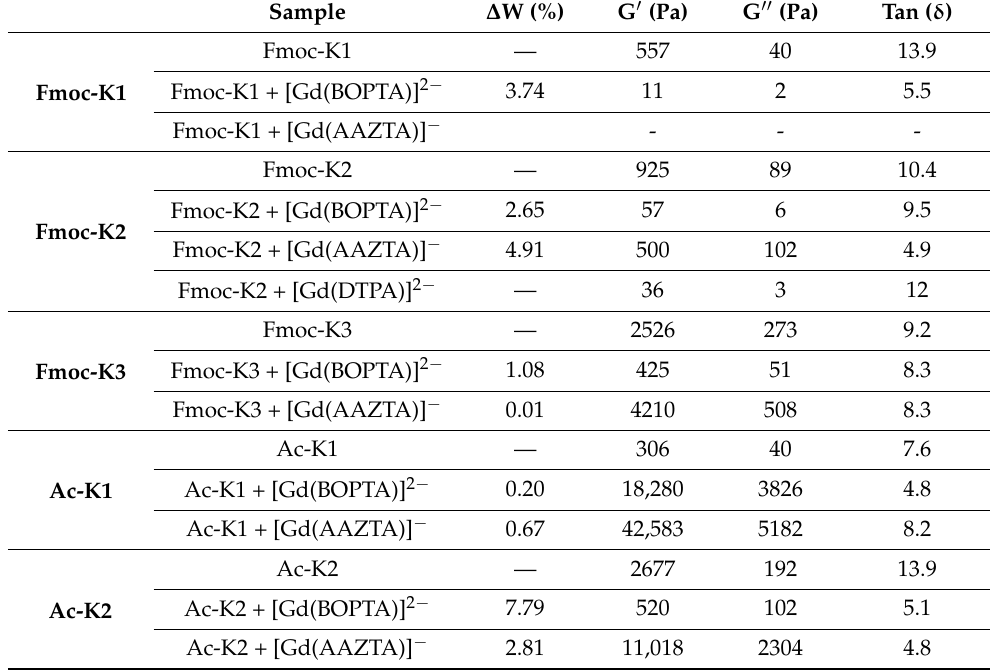
Table 1. Degradation degree, expressed as percentage ratio ( ∆ W), storage modulus (G (cid:48) ), loss mod- ulus (G (cid:48)(cid:48) ) and Tan δ for the different paramagnetic formulations. Rheological parameters of empty hydrogels are also reported for